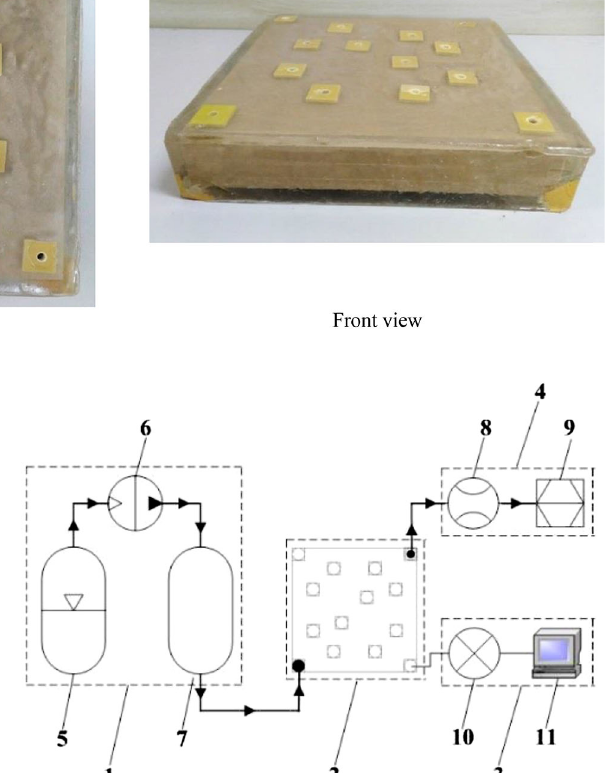
Fig. 1 Design of heterogeneous artificial core plate models Fig. 2 Top view and front view of some artificial core plate model